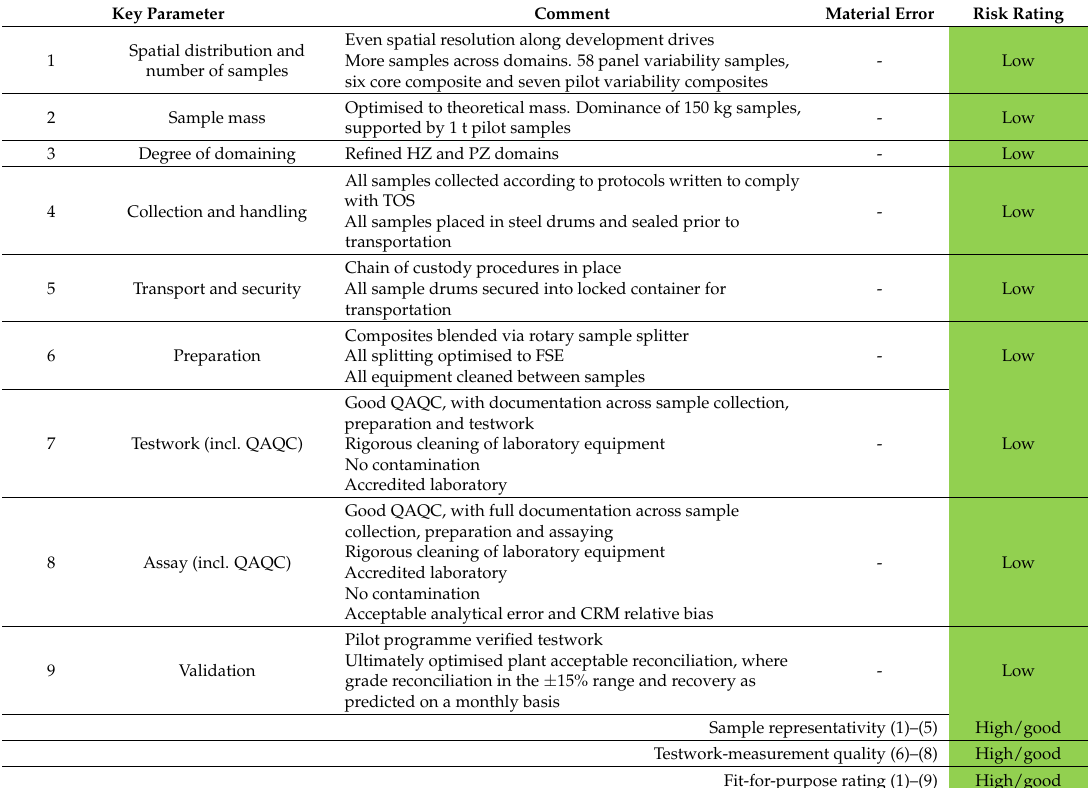
Table 25. Risk review of metallurgical sampling and testwork for case study corrective work programme. Refer to Tables 21 and 22 for QAQC